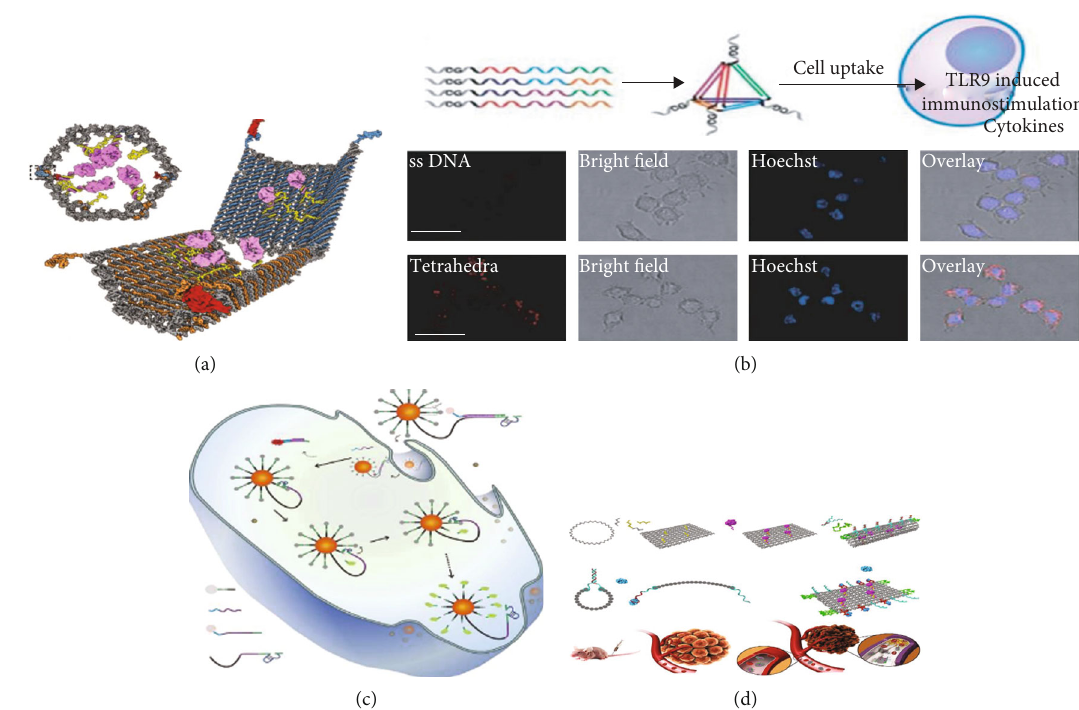
Figure 6: Applications of DNA nanostructures in cell drug delivery [146, 147, 152,